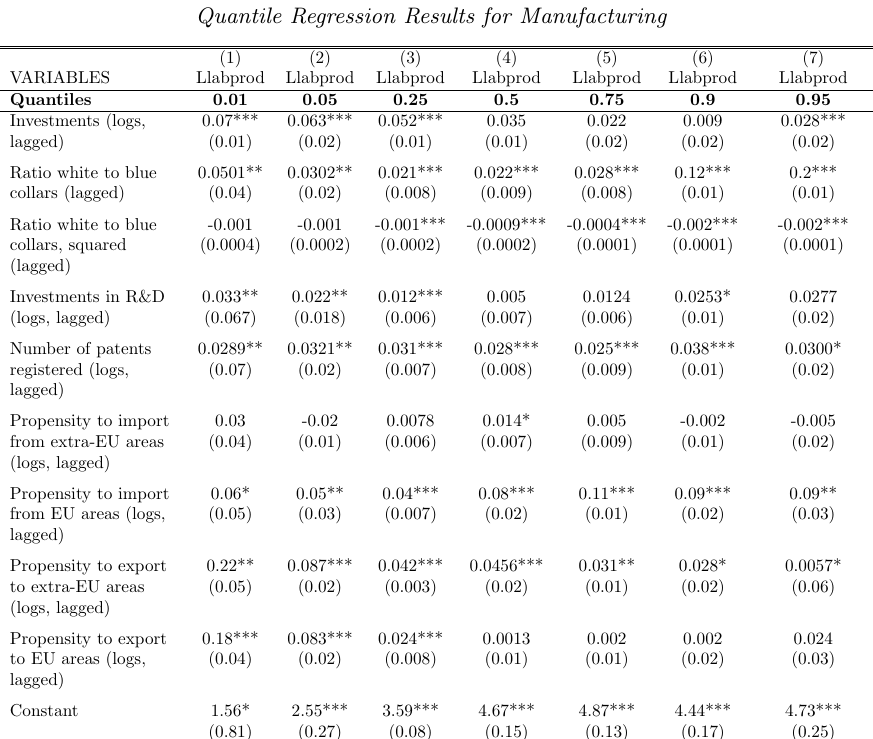
Quantile Regression Results for